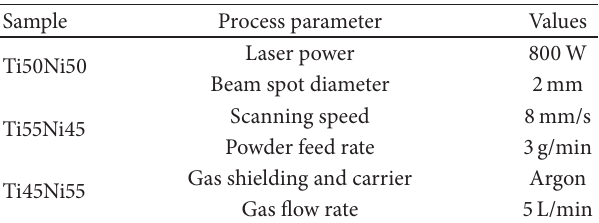
Table 2: Experimental process parameters for depositing the NiTi intermetallic